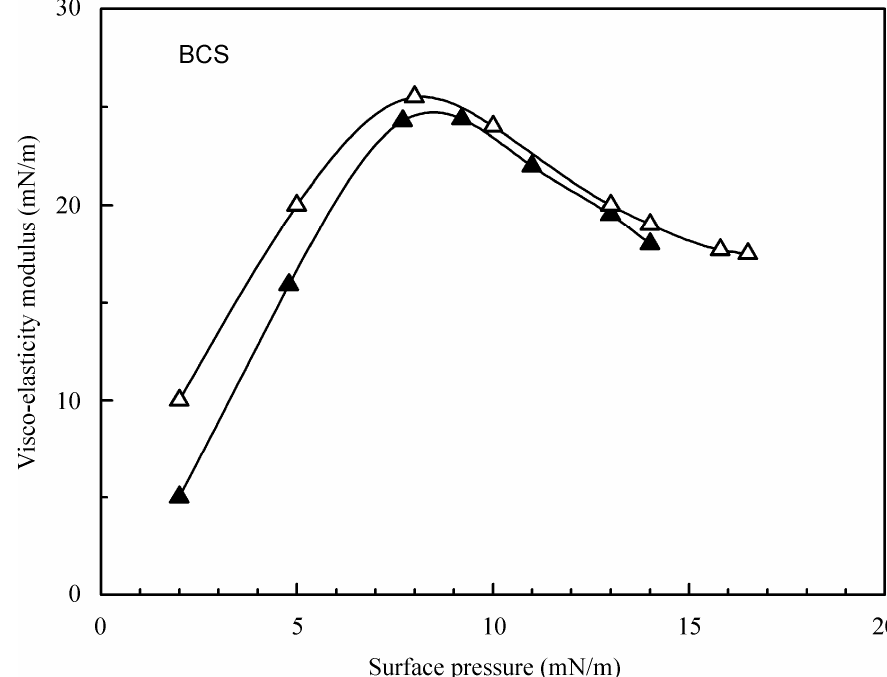
Figure 5. Dependencies of the visco-elasticity modulus of BCS solutions on surface pressure at the adsorption times 5000 s, the frequency 0.1 Hz and the amplitude 10% ( , the data from [24], ▲ , the data obtained in the present study). Table 1. Parameters of Equations 1–7 for proteins adsorbed at the solution/air surface